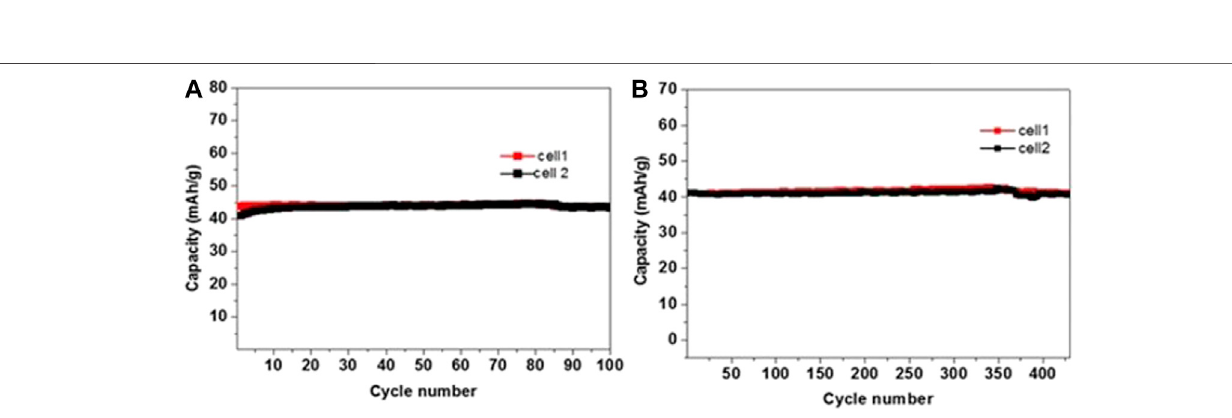
FIGURE 11 | Representative plots of discharge capacity for NMO-PI/saturated NaClO 4 solution full cells in long-term galvanostatic experiments, operating in the 0 – 1.7 V range at (A) C/2 and (B) 2C rate. The reproducibility is demonstrated by showing results from 2 cells in parallel experiments.